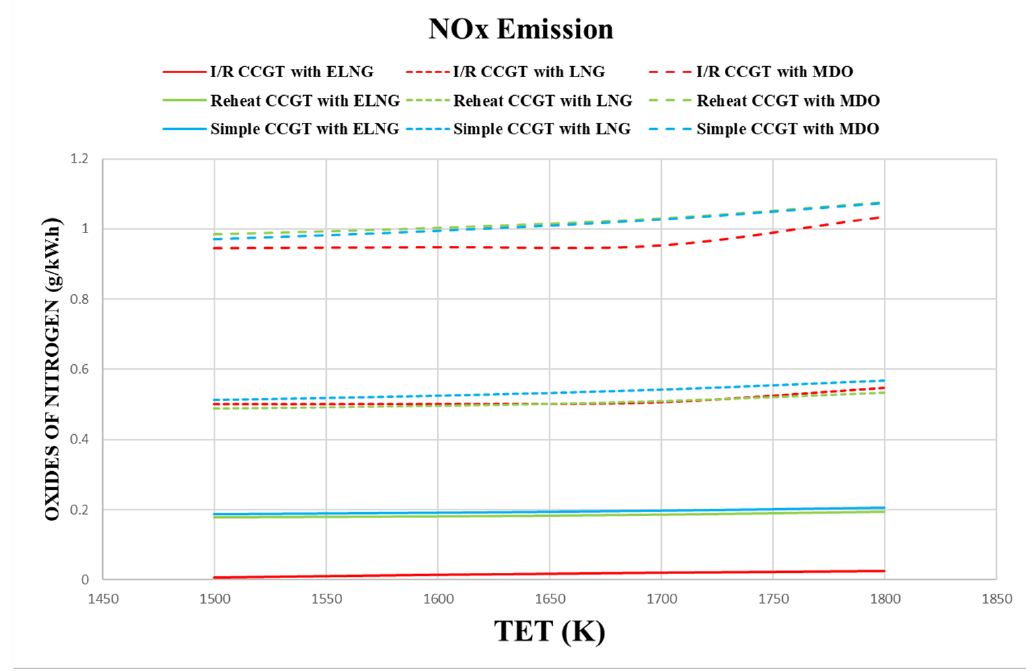
Figure 12. Effects of the TET on the NOx.